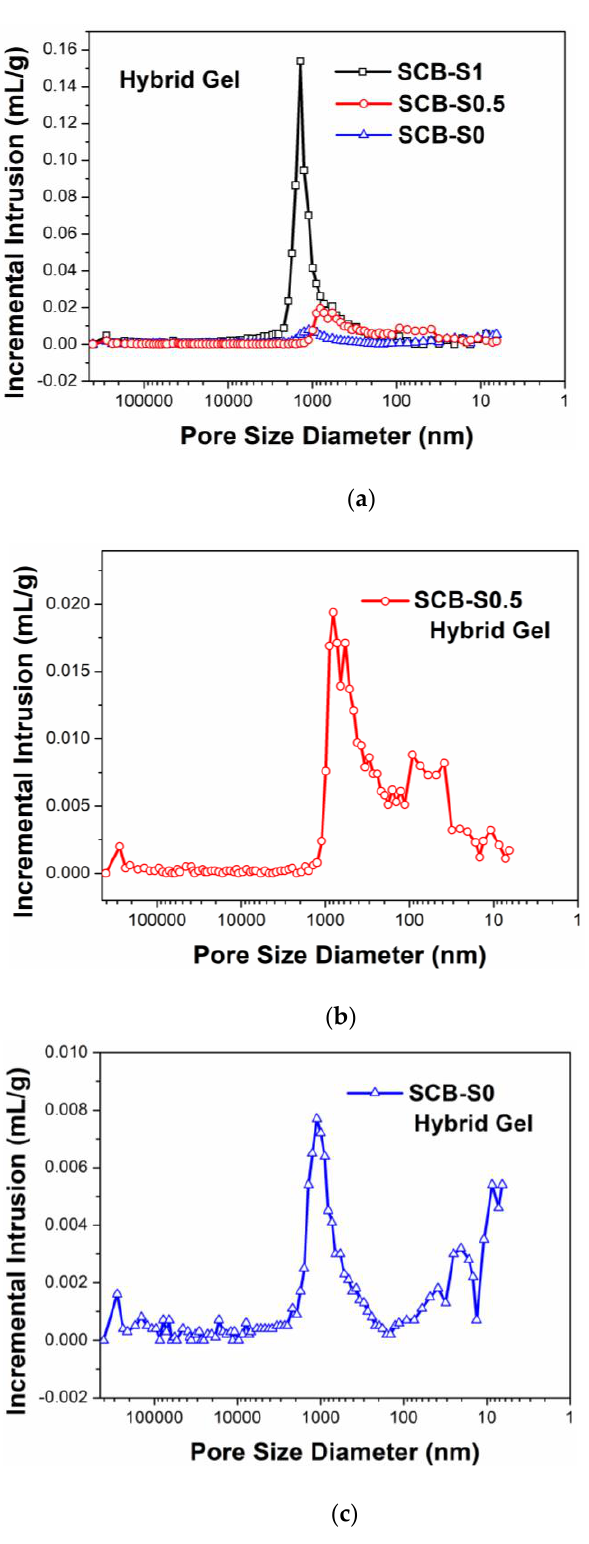
Figure 4. (a) Pore size distribution curves of the hybrid gels. Expanded view of ( b ) SCB-S0.5 and ( c ) SCB-S0 curves.